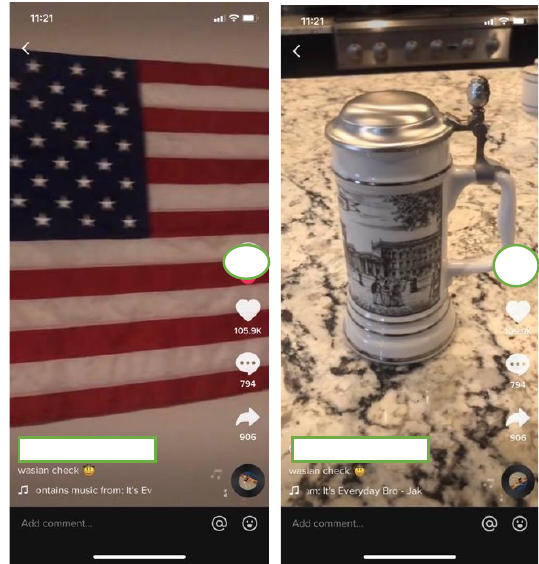
Figure 5. Objects denoting nationality.